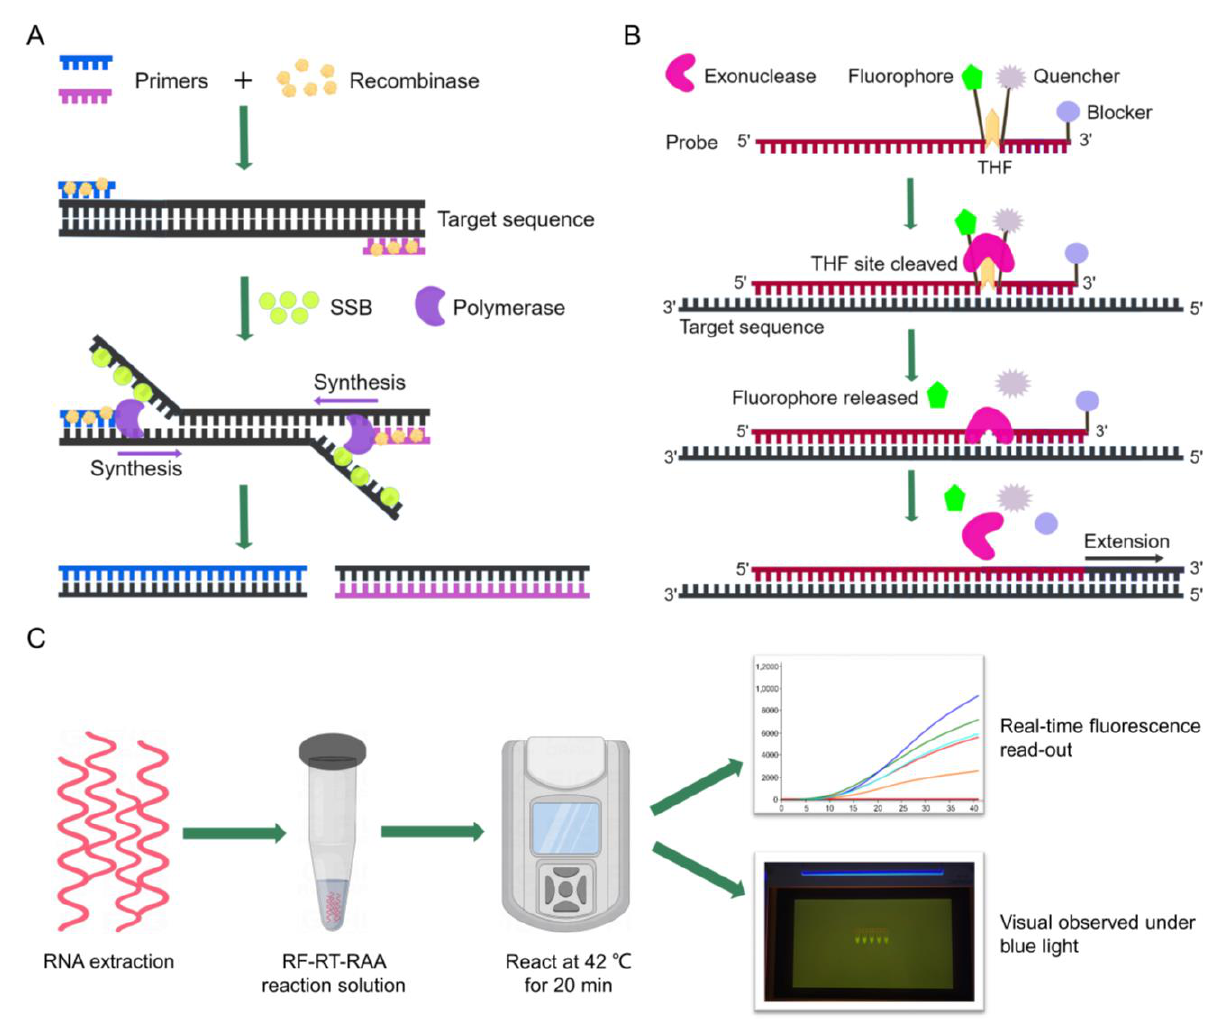
Figure 1. Schematics of RAA-based assay mechanism and RF-RT-RAA detection workflow. ( A ) Process of RAA reaction. ( B ) Principle of real-time fluorescence RAA. ( C ) Workflow of RF-RT-RAA detection. SSB, single-strand DNA binding protein; THF, tetrahydrofuran; RF-RT-RAA, real-time fluorescence-based RT-RAA. This figure was drawn by Figdraw online software (https://www.figdraw.com/ (accessed on 15 September 2022)).